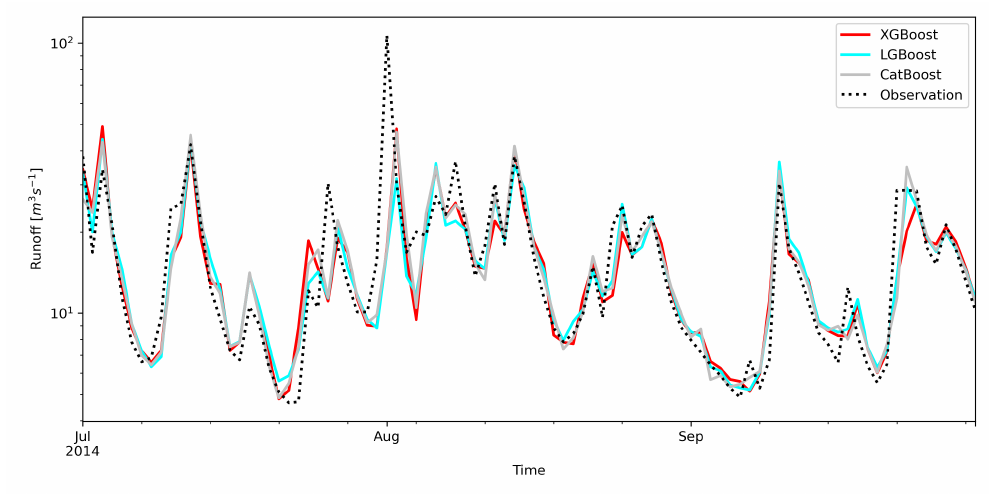
Figure 11. Daily runoff forecast for Wadowice on Skawa River—problem with flood wave peak time.